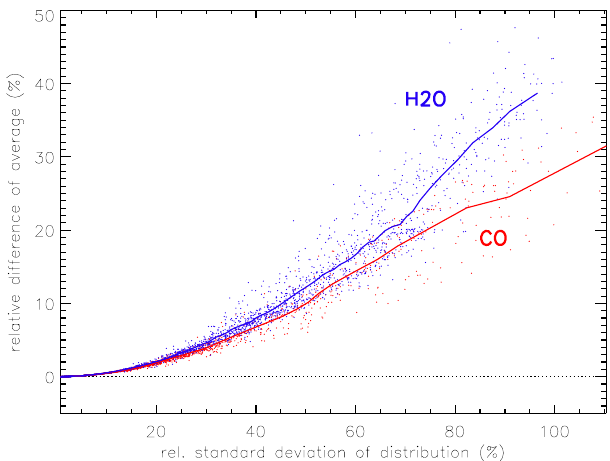
Fig. 2. Differences of linearly and logarithmically averaged zonal means (relative to linearly averaged zonal means) versus standard deviation of the distributions for CO (red) and H 2 O (blue). Data points represent single latitude/altitude